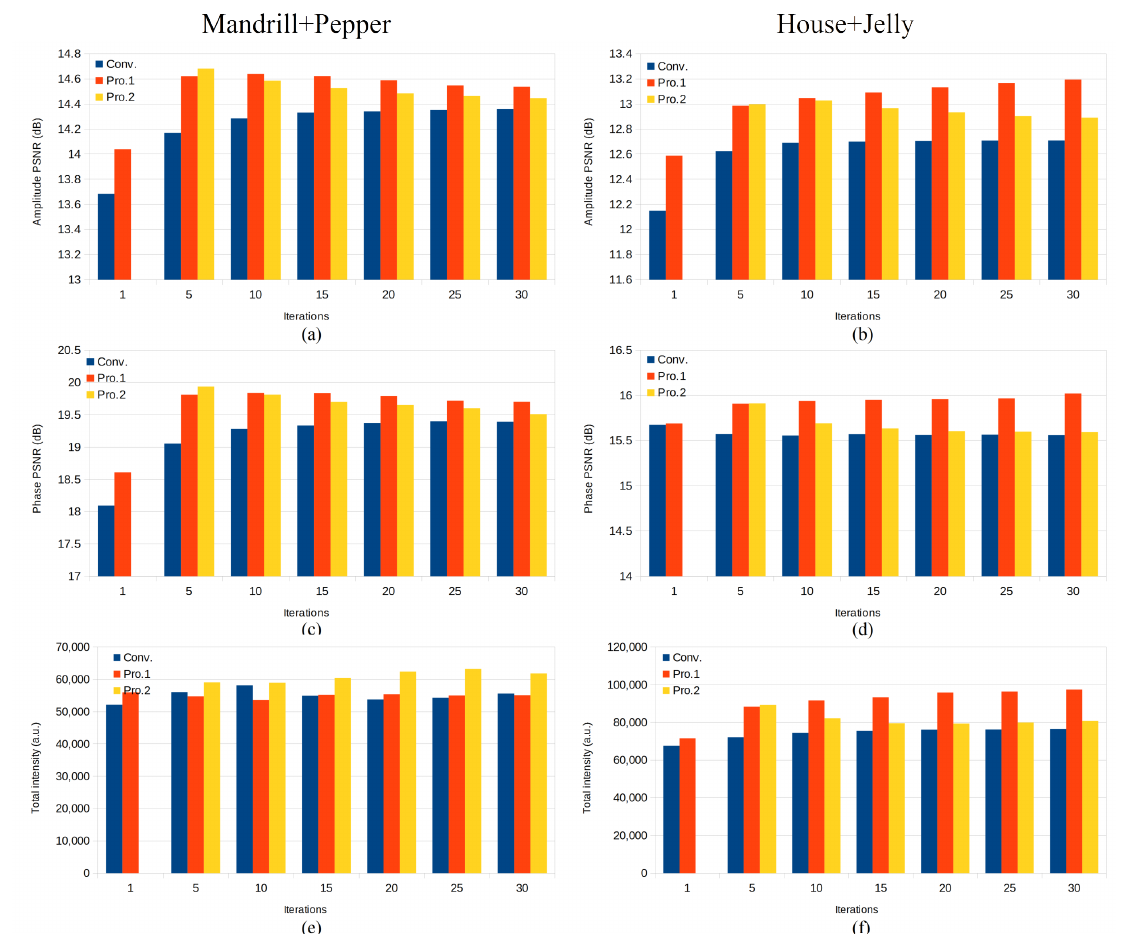
Figure 7. Reconstructed amplitude images, phase images, and total intensity as a function of the iterations. The resolution of the hologram is 512 × 512 pixels. ( a , b ) are the amplitude PSNRs for “Mandrill+Pepper” and “House+Jelly”, ( c , d ) the phase PSNRs for “Mandrill+Pepper” and “House+Jelly”, and ( e , f ) are the total intensities for “Mandrill+Pepper” and